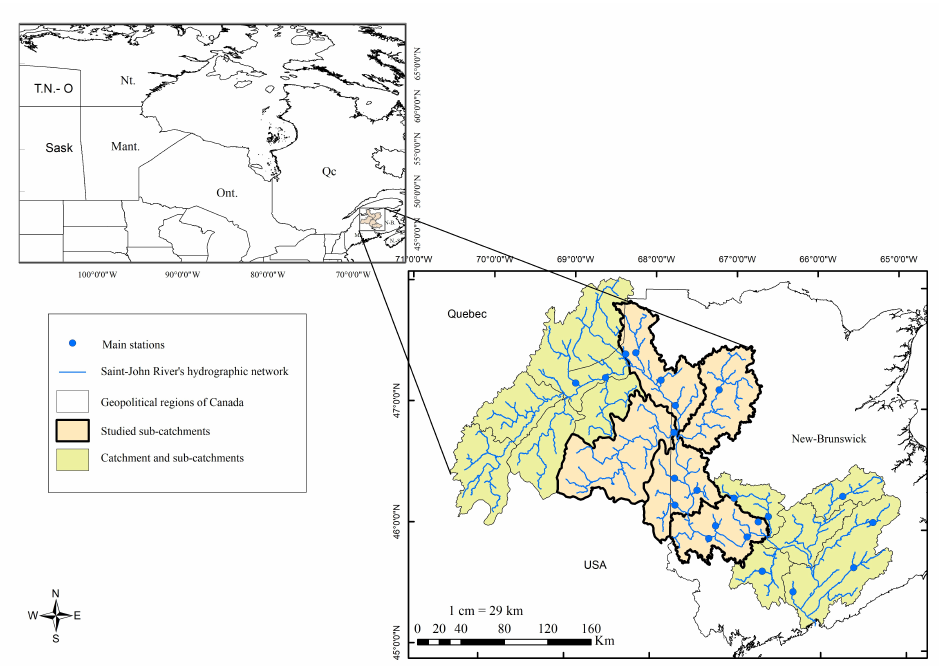
Figure 2. The Saint-John basin and the studied